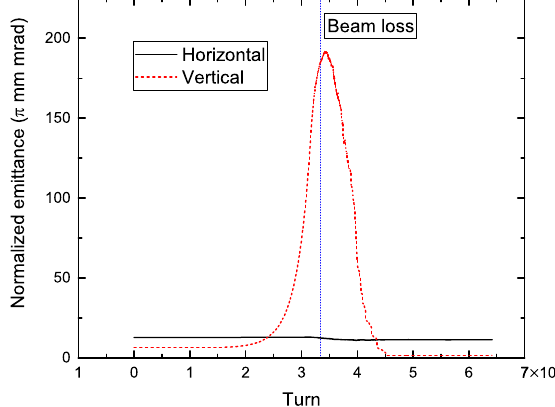
FIG. 7. Normalized emittance in both directions changes over time in the Kr 19 þ simulation. The vertical normalized emittance increases before the beam loss while the horizontal normalized emittance changes a little.